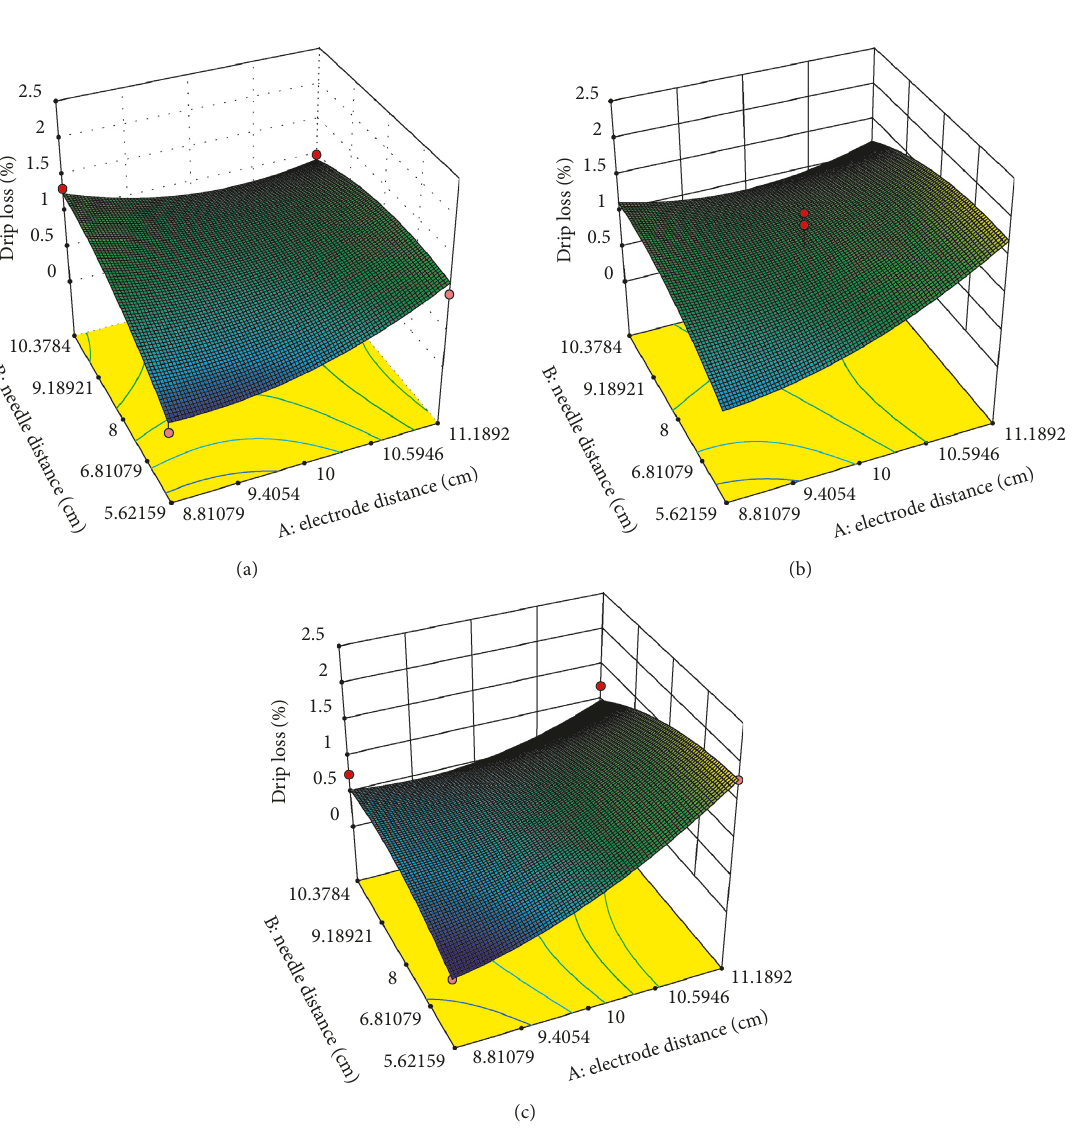
Figure 4: Response surface analysis of electrode distance and needle distance at 15.2kV, 20kV, and 24.8 kV for drip loss of beef. (a) 15.2kV; (b) 20 kV; (c)